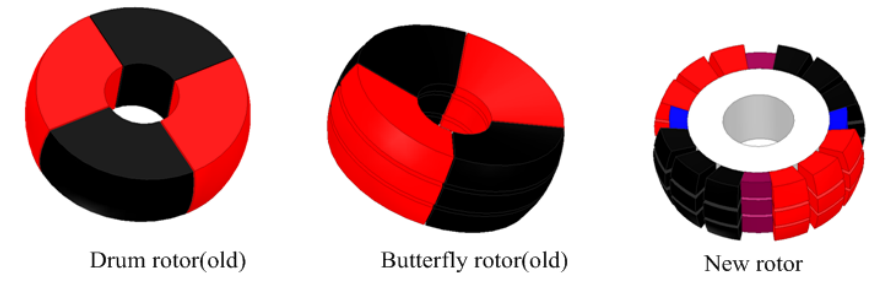
Figure 10. Three different types of rotors. Figure 10. Three di ff erent types of rotors.